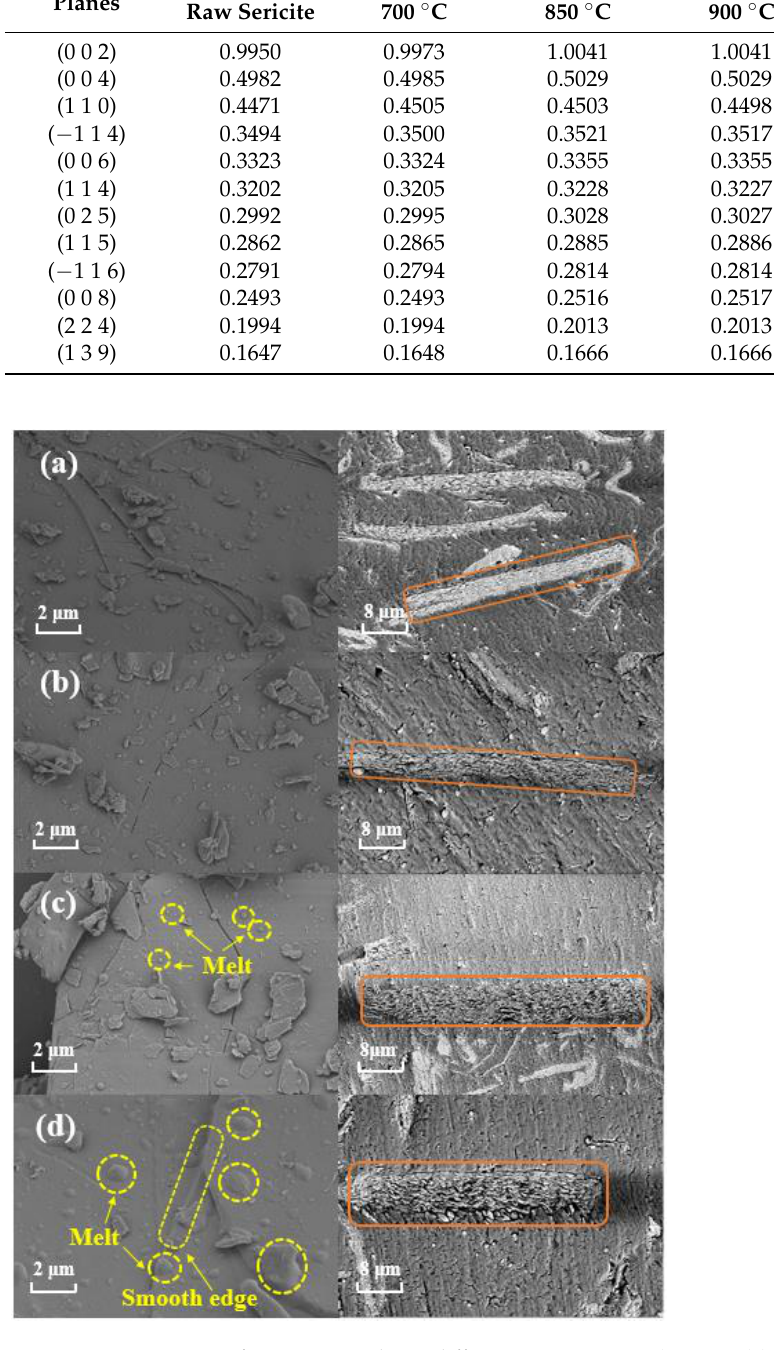
Figure 7. SEM images of sericite samples at different temperatures (raw ore ( a ), 850 °C ( b ), 950 °C ( c ), and 1050 °C ( d )).